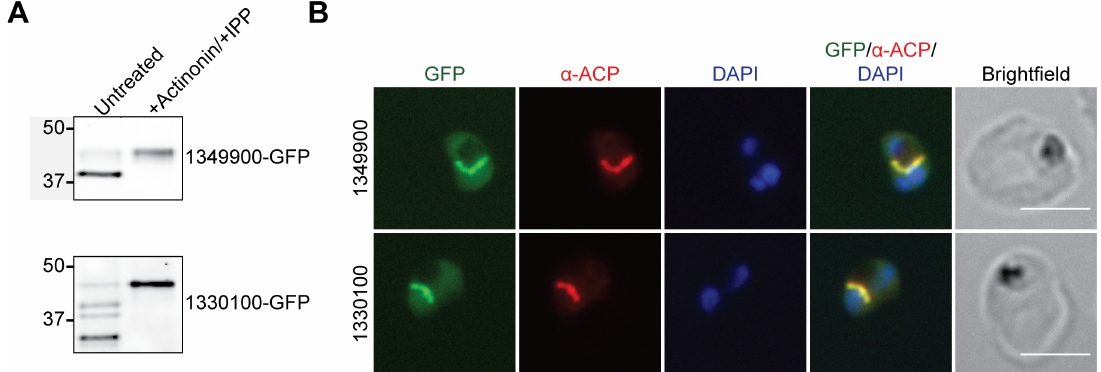
Fig 7. Localization of candidate apicoplast proteins identified by PlastNN. (A) Transit peptide processing assay for C -terminally GFP- tagged candidates. Ring-stage parasites were either untreated or treated with 10 μM actinonin/200 μM IPP for 3 days and protein processing was assessed by western blot. (B) Fixed-cell imaging of GFP-tagged candidates in parasites stained with an antibody raised against the apicoplast marker ACP. Scale bars, 5 μm. ACP, acyl carrier protein; GFP, green fluorescent protein; IPP, isopentenyl pyrophosphate; PlastNN, Apicoplast Neural